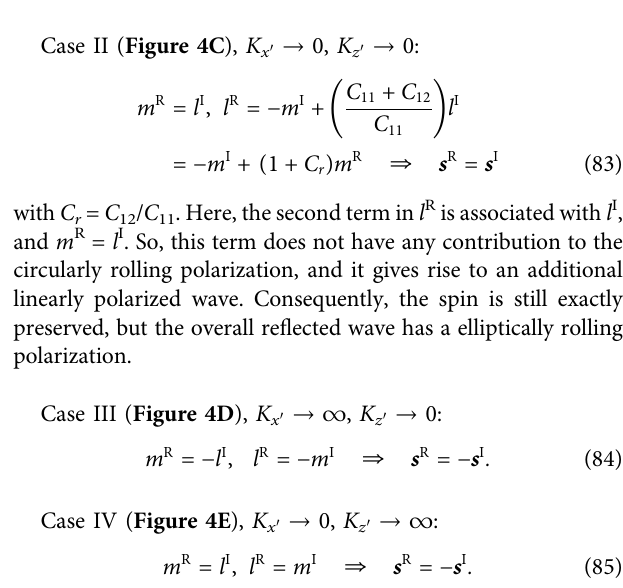
(cid:2)− 0.5, C (cid:2) 0, C (cid:2) 0.5and C (cid:2) 1,respectively.Notethatallpolarizationsarescaledforthepurpose r r r r